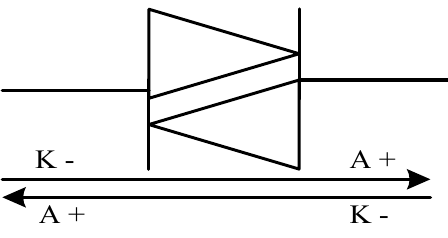
Figure 13. Schematic symbol of a diode AC switch (Diac) [139].